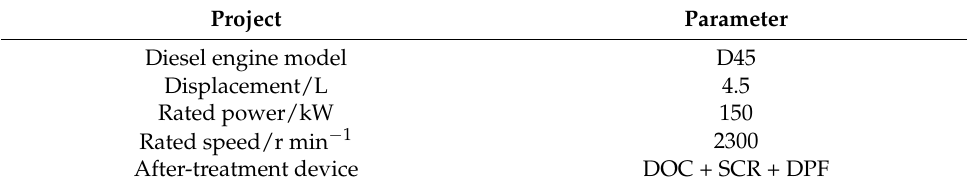
Table 2. Parameters of the diesel engine.